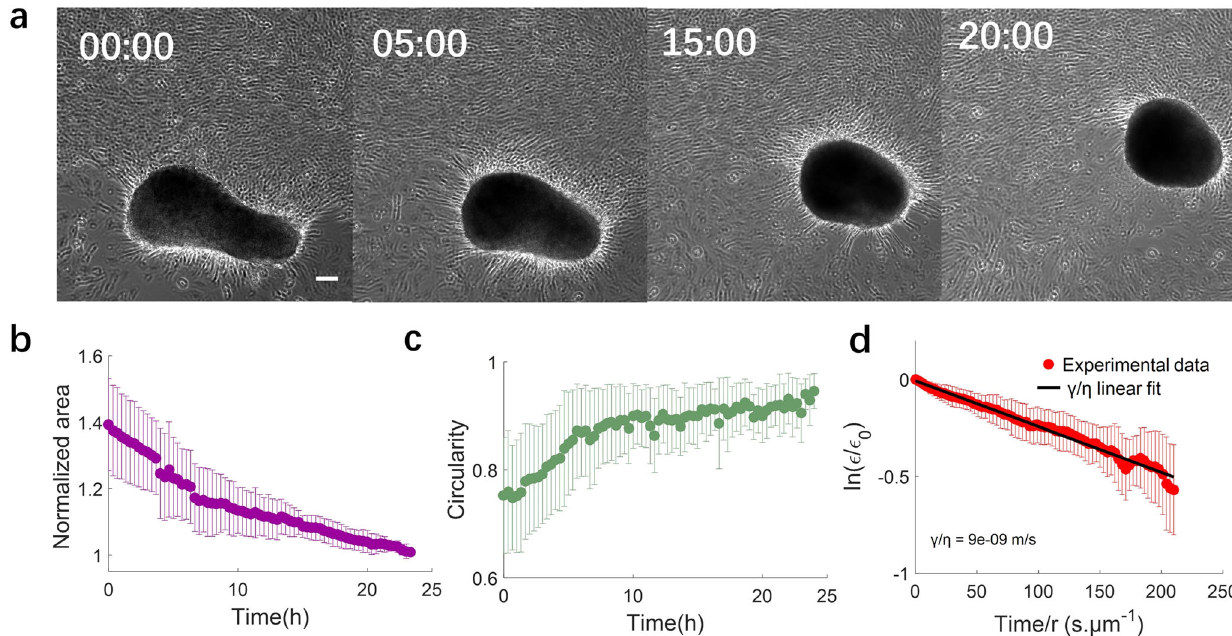
Fig. 3 Cluster rounding dynamics. a Phase contrast images of a SMC cluster at different times showing progressive rounding. Times are in hours. Scale bar: 100 μ m. b Time evolution of normalized cluster projected area. c Time evolution of cluster circularity de fi ned as 4 π A / P 2 , where A is cluster area and P is cluster perimeter. d Normalized cluster/spheroid anisotropy, allowing determination of the value of the ratio of surface tension to viscosity ( γ / η ). γ / η ~10 -8 m/s. Equation is indicated in the text. b – d Mean± SD, N = 7.